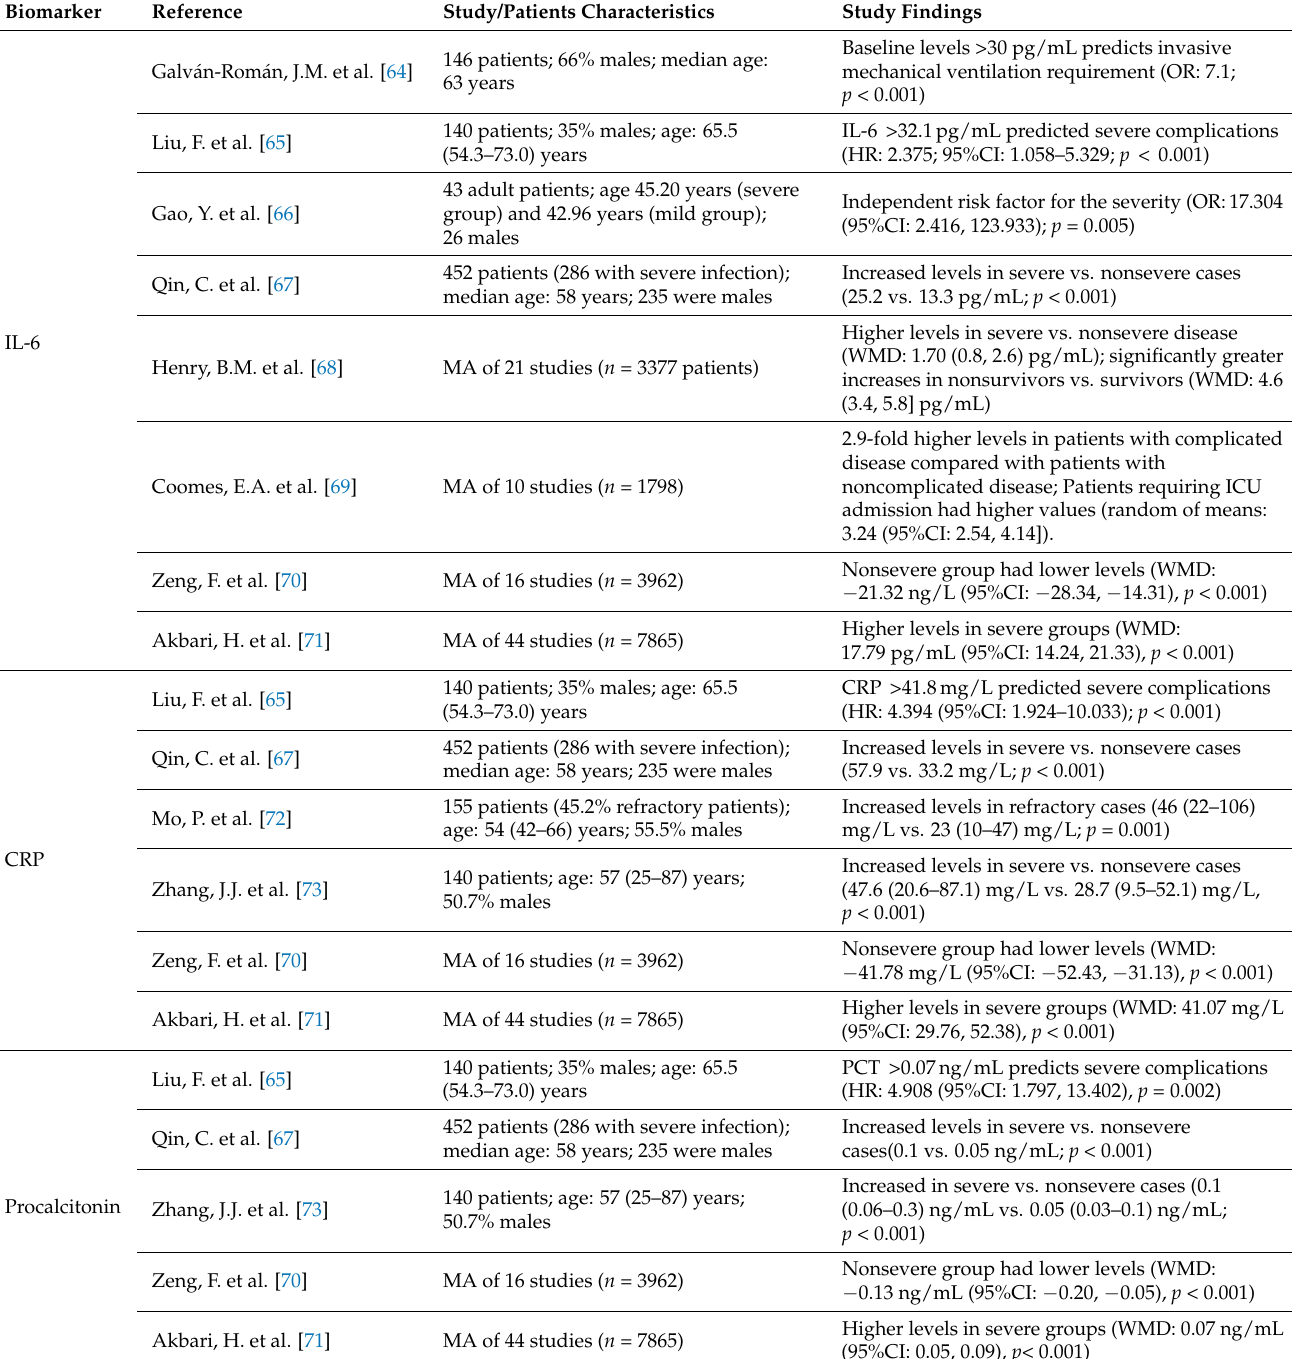
Table 1. Chronic inflammatory markers in COVID-19